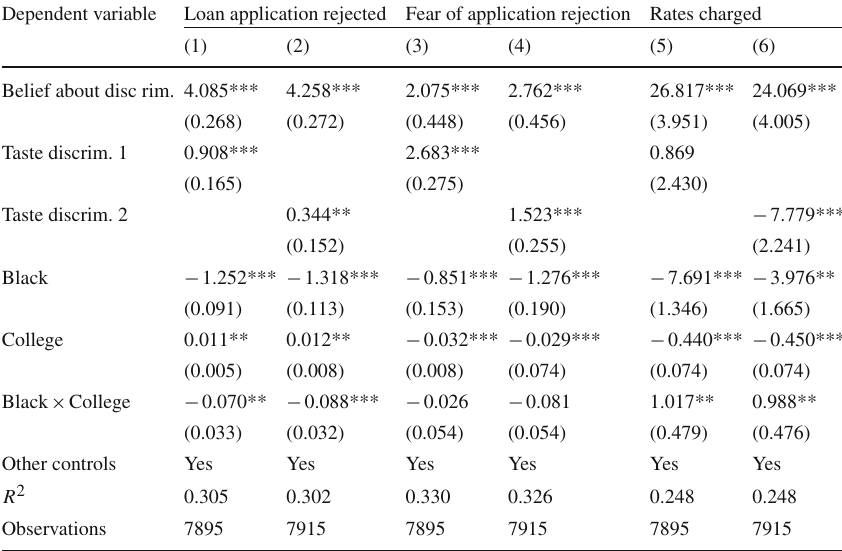
Table 3 OLS of loan application. Source : General Social Survey, National Survey of Small Business and Finance Dependent